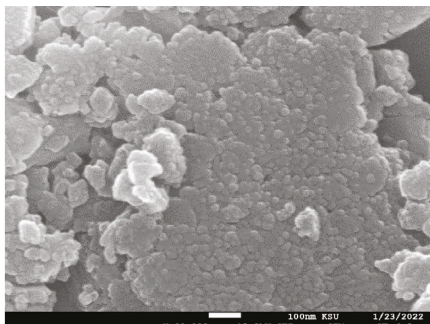
Figure 18: SEM image of V